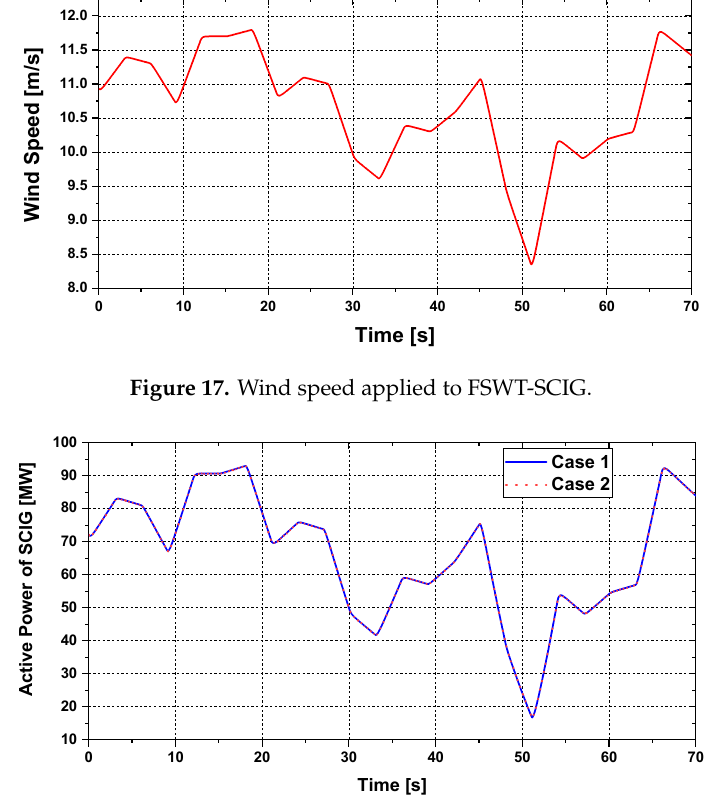
Figure 18. Real power response of FSWT-SCIG.